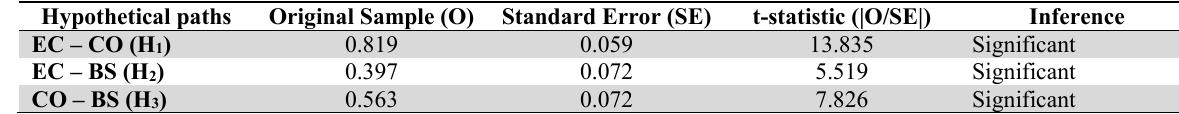
Path coefficient and t-statistic value